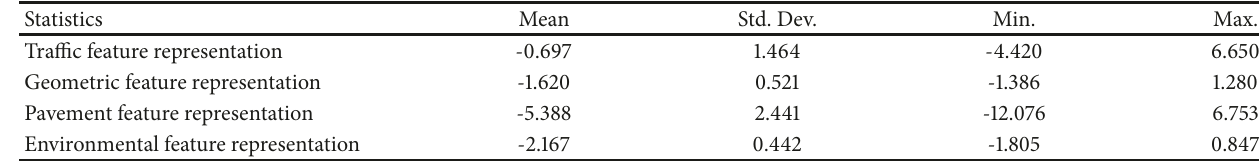
Table 4: Summary statistics of feature representations.